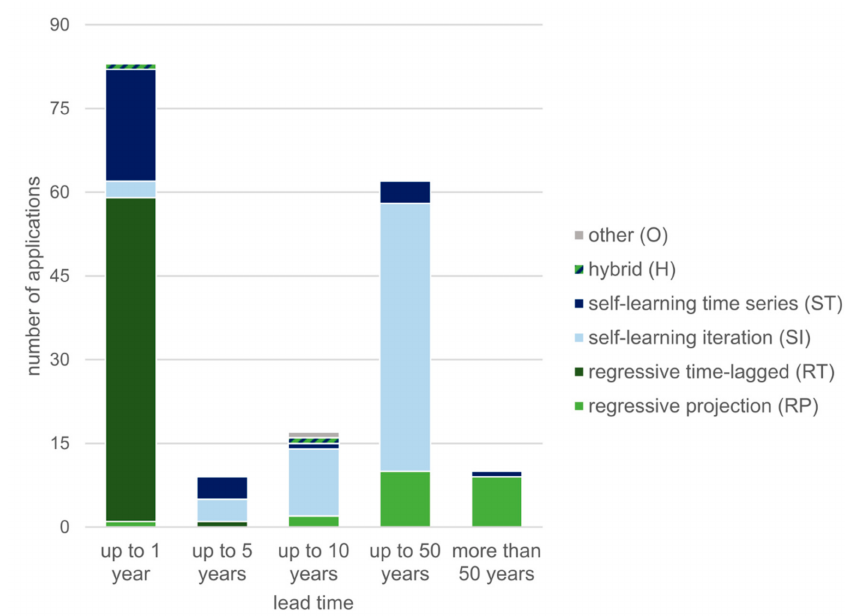
Figure 10. Number of forecast applications and forecasting lead times according to the forecasting method